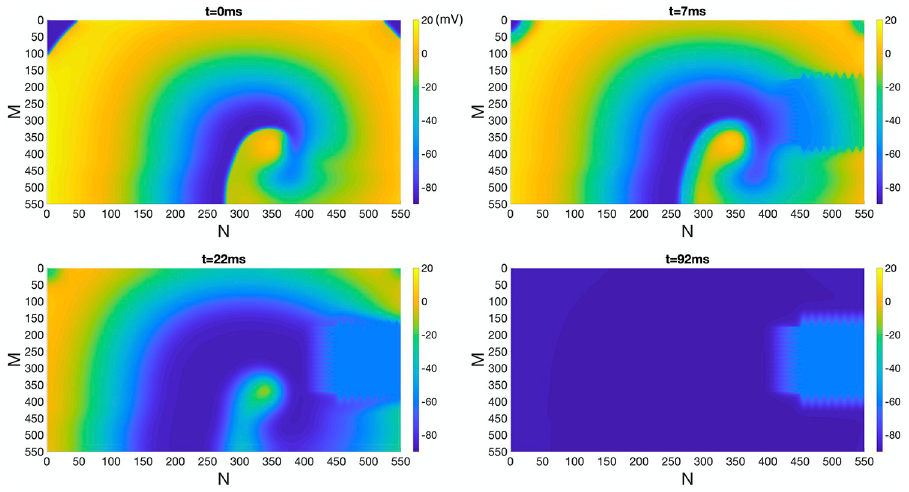
Fig 9. Inhibition of reentry under homogeneous EpC and IC BZ with complex geometry (right). Suppression of reentry in the presence of homogeneous EpC ( d cleft = 8 nm) and BZ with complex geometry to the right of the lattice. (in the unit of mV). Snapshots of V at time = 0 ms, 7 ms, 22 ms and 92 ms are Colorbar indicates V m m